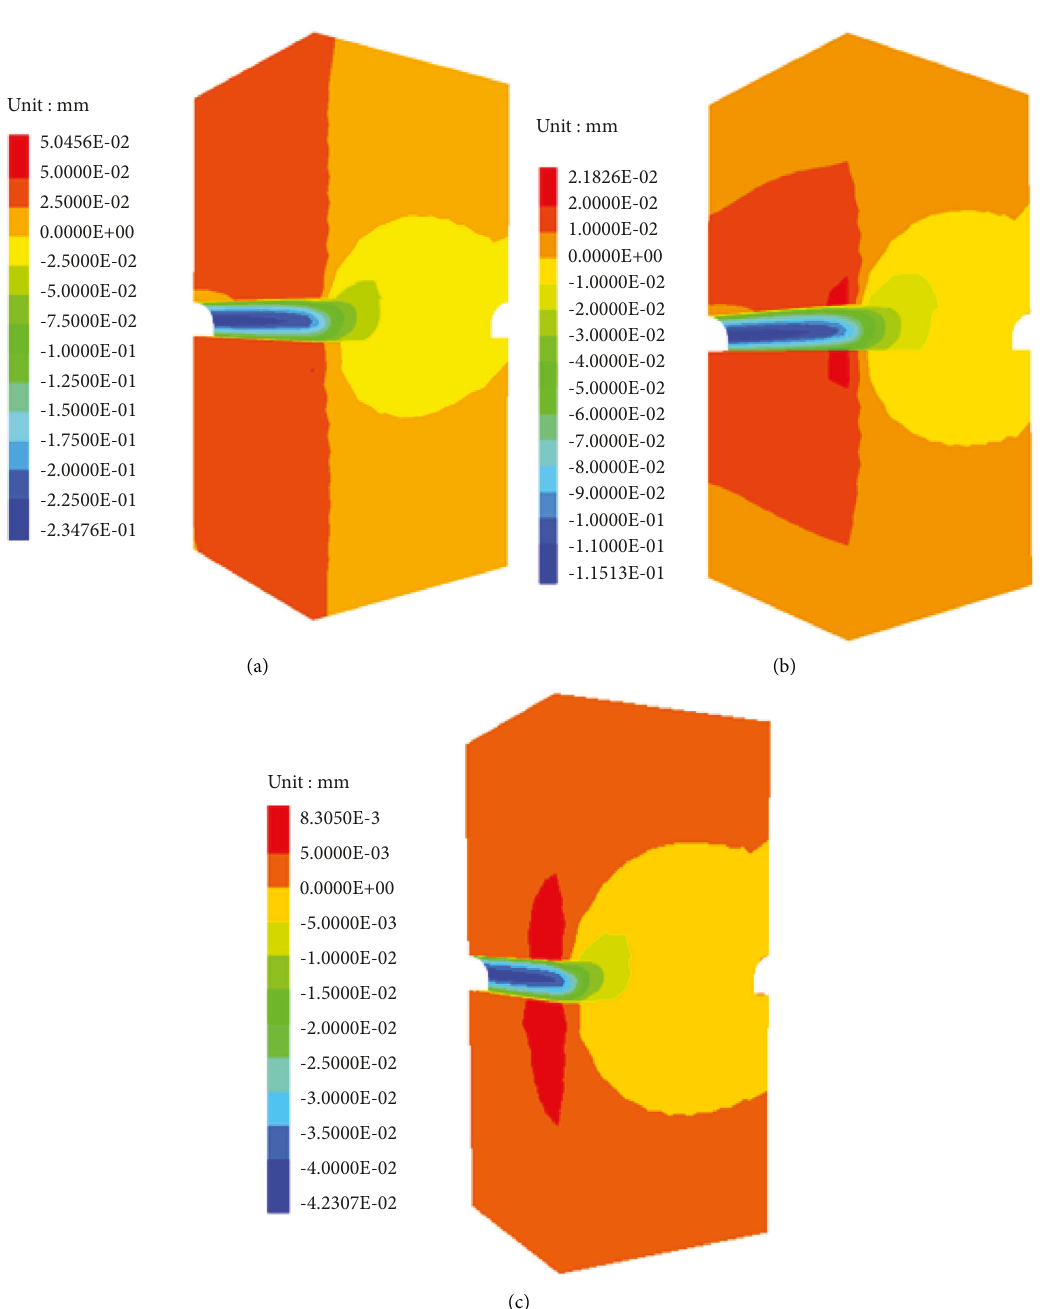
Figure 7: Horizontal displacement field, (a) original support system, (b) high prestressed constant resistance coupling support system, (c) dual-control constant-resistance coupling control